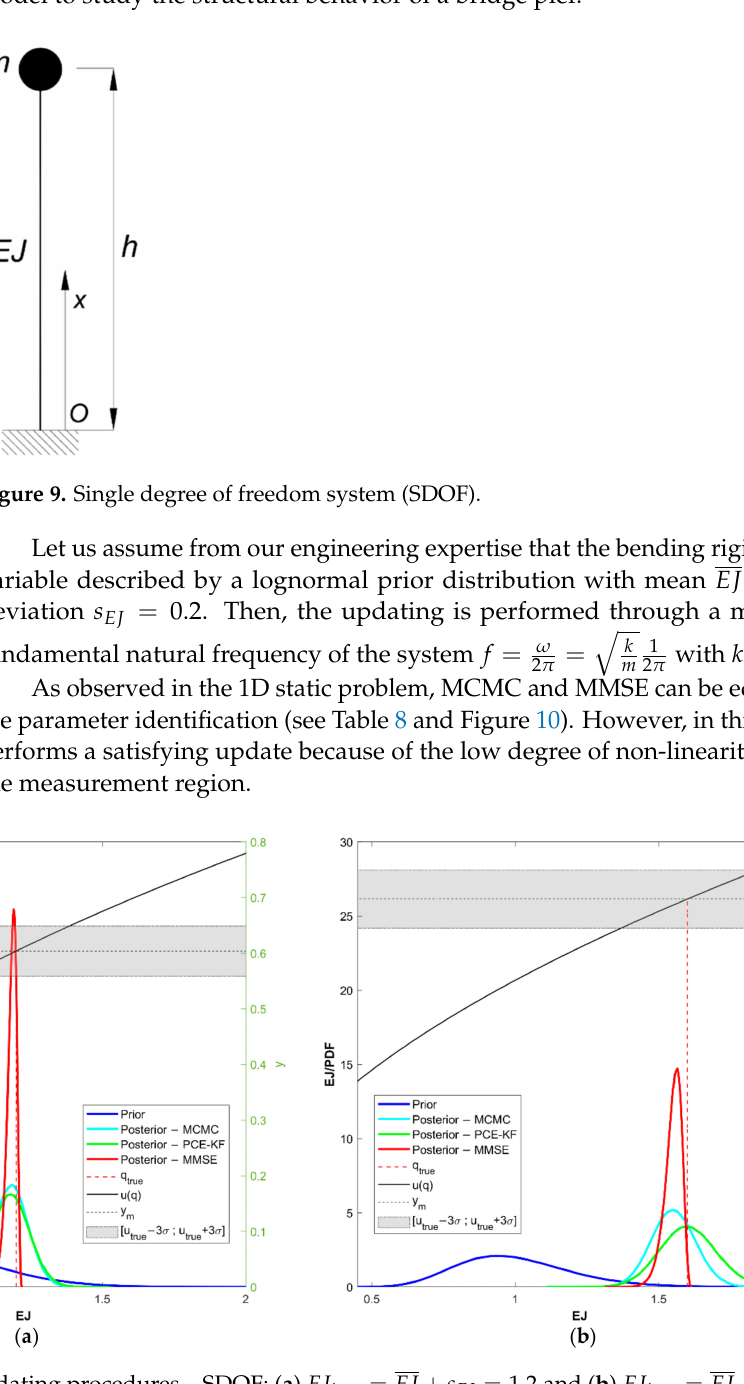
Figure 10. Comparison of updating procedures—SDOF: ( a ) EJ true = EJ + s EJ = 1.2 and ( b ) EJ true = EJ + 3 s EJ = 1.6. In each figure, the following are reported: the prior PDF (in blue); the posterior PDFs obtained via MCMC (in cyan), via PCE-KF (in green) and via NL-MMSE (red solid line); the true value of the parameter q true (red dashed line); the model response u ( q ) (black solid line); the measurement y m (black dashed line); the ± 3 σ ε region of the measurement (grey